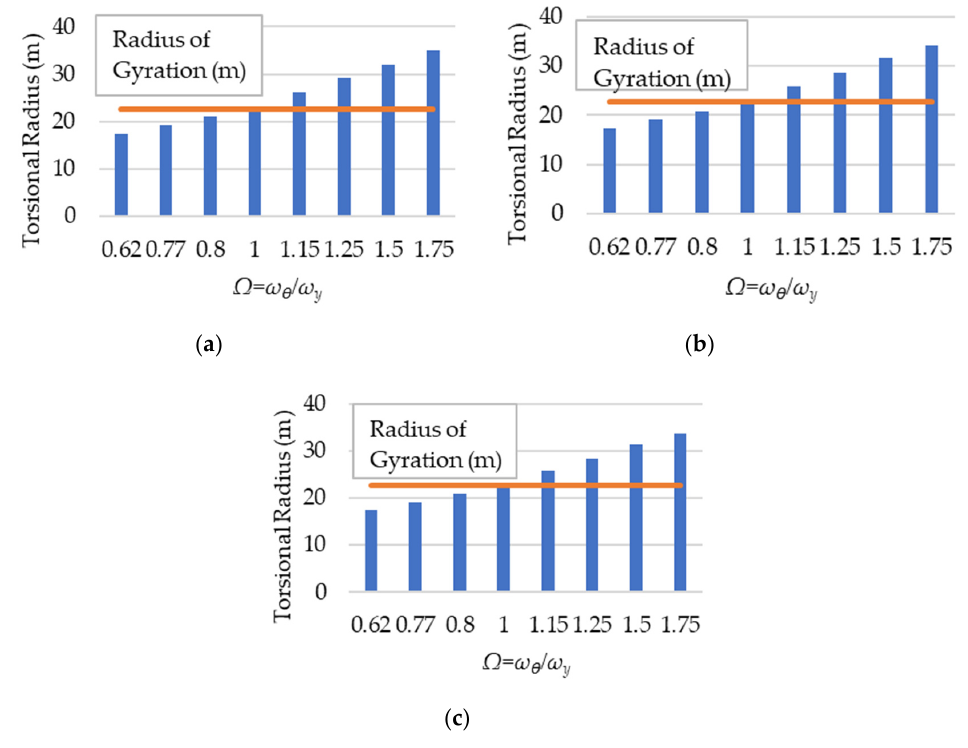
Figure 15. Torsional radius for buildings with ( r = 22.7 m & b/r = 1.40): ( a ) Building period T < 1 s; ( b ) Building period 1 < T < 2 s; ( c ) Building period T > 2 s.